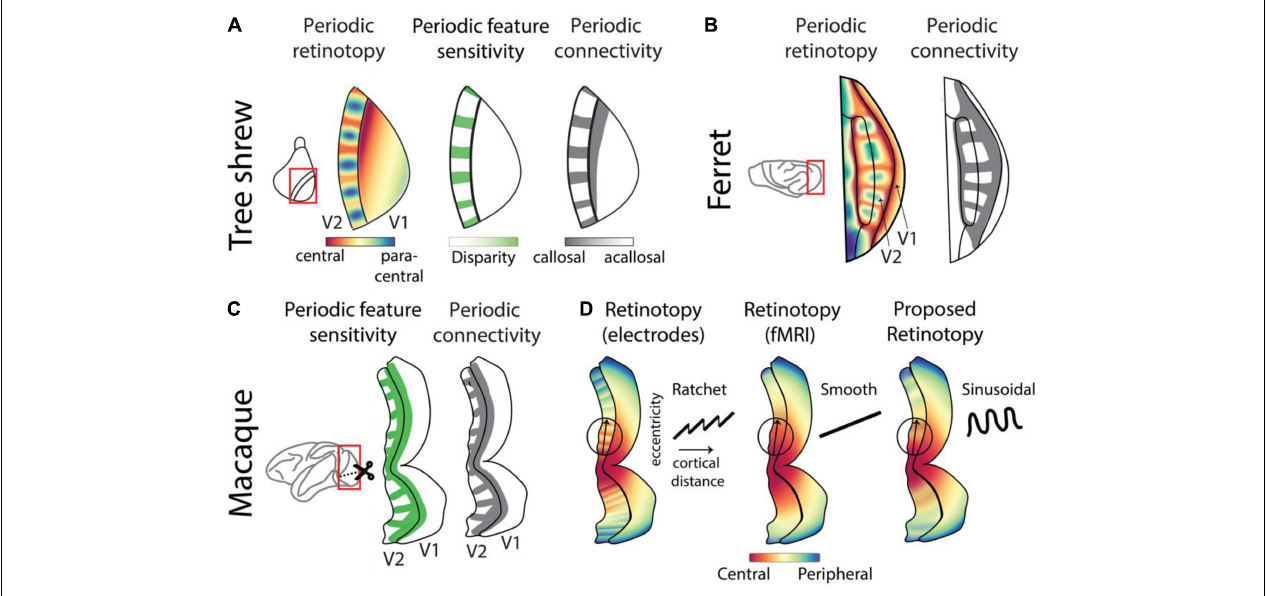
FIGURE 4 | Complex retinotopy highlights location-dependent feature sensitivity across species. (A) The complex retinotopy map in tree shrew V2 highlights the joint distribution of spatial location, disparity sensitivity, and anatomical connectivity. Regions of V2 that are sensitive to the most central regions of the binocular visual field are also sensitive to retinal disparity cues and receive callosal inputs which carry information from V1 of the opposite hemisphere (Sedigh-Sarvestani et al., 2021). (B) A similar periodic retinotopy, with corresponding periodic pattern of callosal inputs, has been observed in ferret V2 (Manger et al., 2002; Rosa and Manger, 2005). (C) Periodic patterns of feature sensitivity, including retinal disparity, are well-known in macaque V2 (Hubel and Livingstone, 1987; Lu et al., 2010; Hubel et al., 2015). Callosal projections exhibit a corresponding periodicity (Olavarria and Abel, 1996), suggesting that retinotopic sensitivity may also exhibit a periodic pattern similar to that in tree shrews or ferrets. (D) Reports of retinotopy in macaque V2 differ based on methodology. When measured using invasive single-cell electrodes, retinotopy has been reported as a “ratchet” model (Roe and Ts’o, 1995; Shipp and Zeki, 2002) with smooth increases interleaved with sudden resets in receptive field position. When measured with the coarser resolution of fMRI, smooth maps were reported (Nasr et al., 2016; Li et al., 2019). We propose that optical imaging measurements which combine single-cell resolution with widefield coverage would exhibit sinusoidal retinotopy overlying a smooth gradient, similar to our observations in tree shrews and